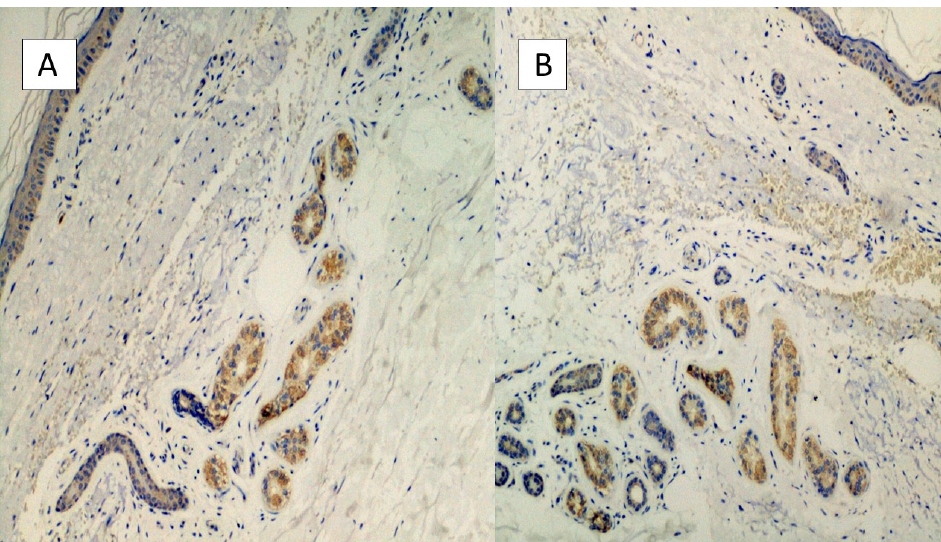
Figure 3. ( A , B ) Histological preparation for immunostaining with Anti-SARS-CoV-2 monoclonal antibody. Note the granular, cytoplasmic positivity at the level of the cells constituting the eccrine sweat glands. Involvement of the vascular endothelium is rarely described (IHC, Original Magnification: 10 ×).